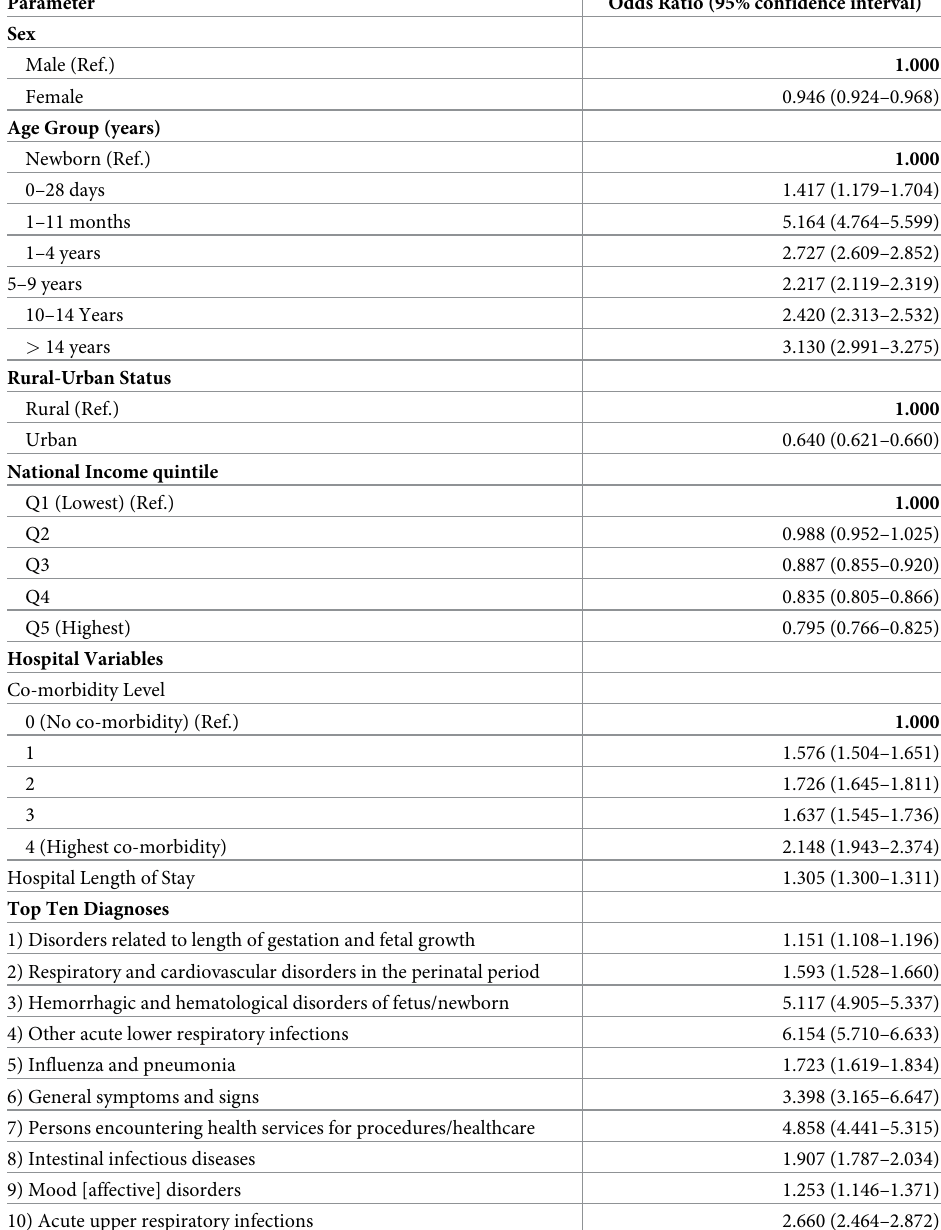
Table 4. Predictors of being a high hospital